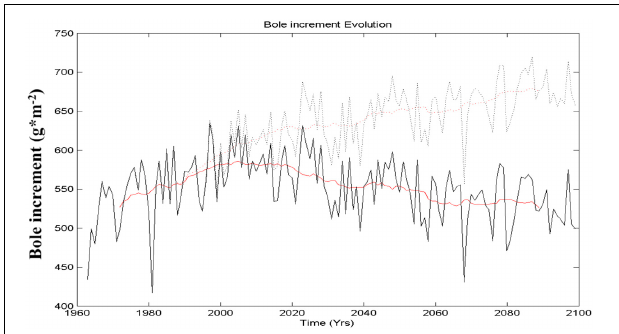
FIGURE 3 | Evolution of the mean annual production of Pinus halepensis for southeast France simulated by MAIDEN on the basis of the ARPEGE B2 scenario, with (dark line) and without (dotted line) the fertilization effect of CO 2 (MCMC calibration). The black lines are the non smoothed values and the red lines are the smoothed values. Vertical axis represents bole annual increment in grams of carbon per square meter. Adapted from Gaucherel et al.